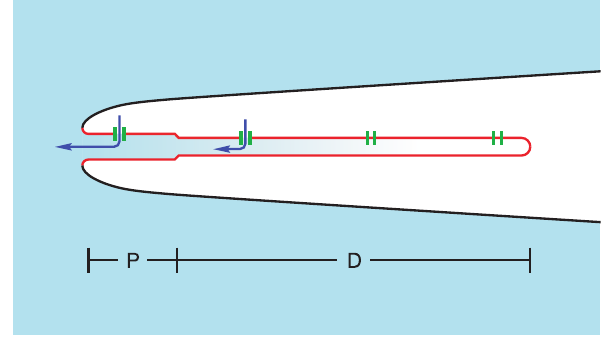
Figure 1. Schematic diagram of the experimental method. A single cilium (shown in red) from a frog ORN is sealed inside a glass micropipette (black). The base of the cilium, which is attached to the dendrite in vivo, is shown at the left. The distal tip is at the right. The base of the cilium is open and allows diffusion of Ca 2 + (light blue) from the surrounding bath into the cilium. As Ca 2 + reaches Cl 2 channels (green) in the ciliary membrane, it gates them, allowing an inward current (efflux of Cl 2 , dark blue arrows). The uniform distribution of channels shown does not represent the experimental finding. At the bottom are shown the approximate extents of the proximal (P) and distal (D) segments of the cilium as described by Reese [11]. Only the relative diameters and the relative lengths of the proximal and distal segments are drawn to scale. Reprinted from [9], Flannery et al. (2006), copyright 2006, with permission from